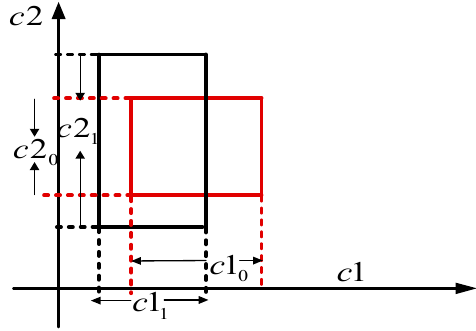
Figure 10. Stability boundaries of two uncertainty parameters.